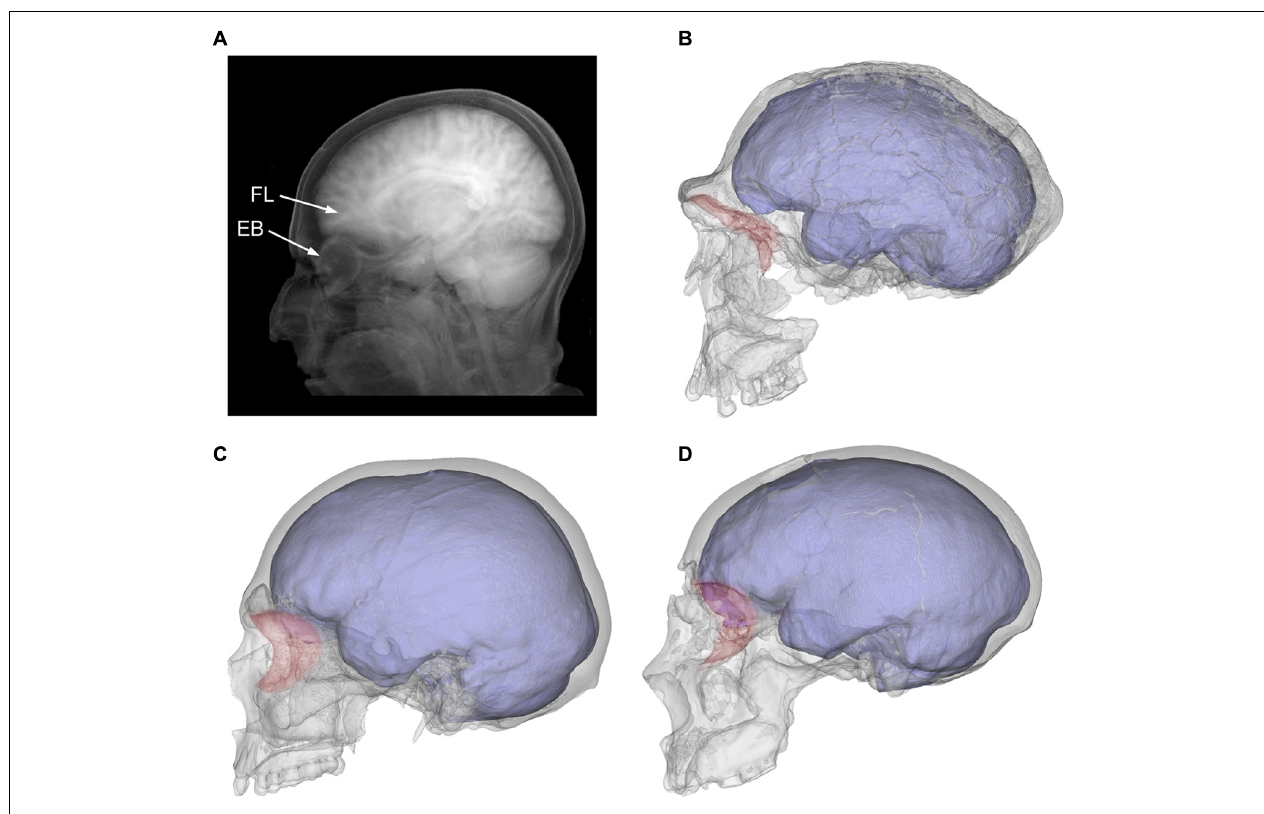
FIGURE 3 |The tomographic projection shows the intimate proximity between frontal lobes (FL) and the eyeball (EB) in a modern human individual (A). The orbits (in red) were separated from the anterior cranial fossa in archaic humans like Homo ergaster ( B ; KNM-ER 3733), but moved